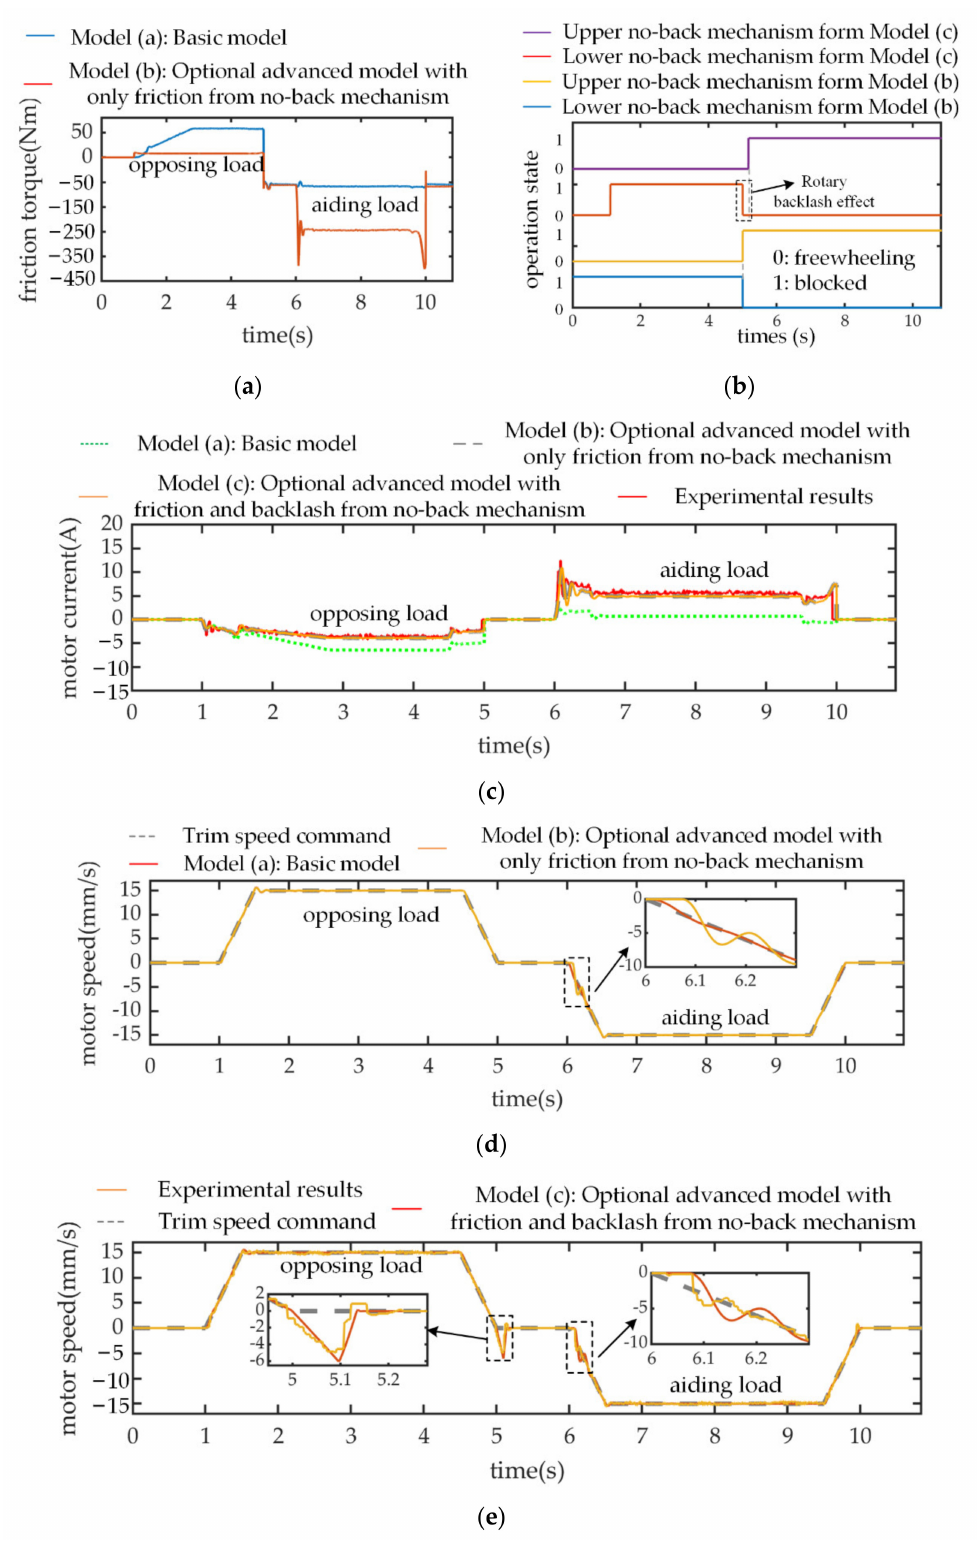
Figure 8. Simulation responses and experimental results under bipolar speed command and ramp load. ( a ) No-back friction torque; ( b ) Operation state of pawl and ratchet wheel; ( c ) Motor current response; ( d ) Trim speed response from models ( a , b ); ( e ) Motor speed response from model ( c ) and experimental